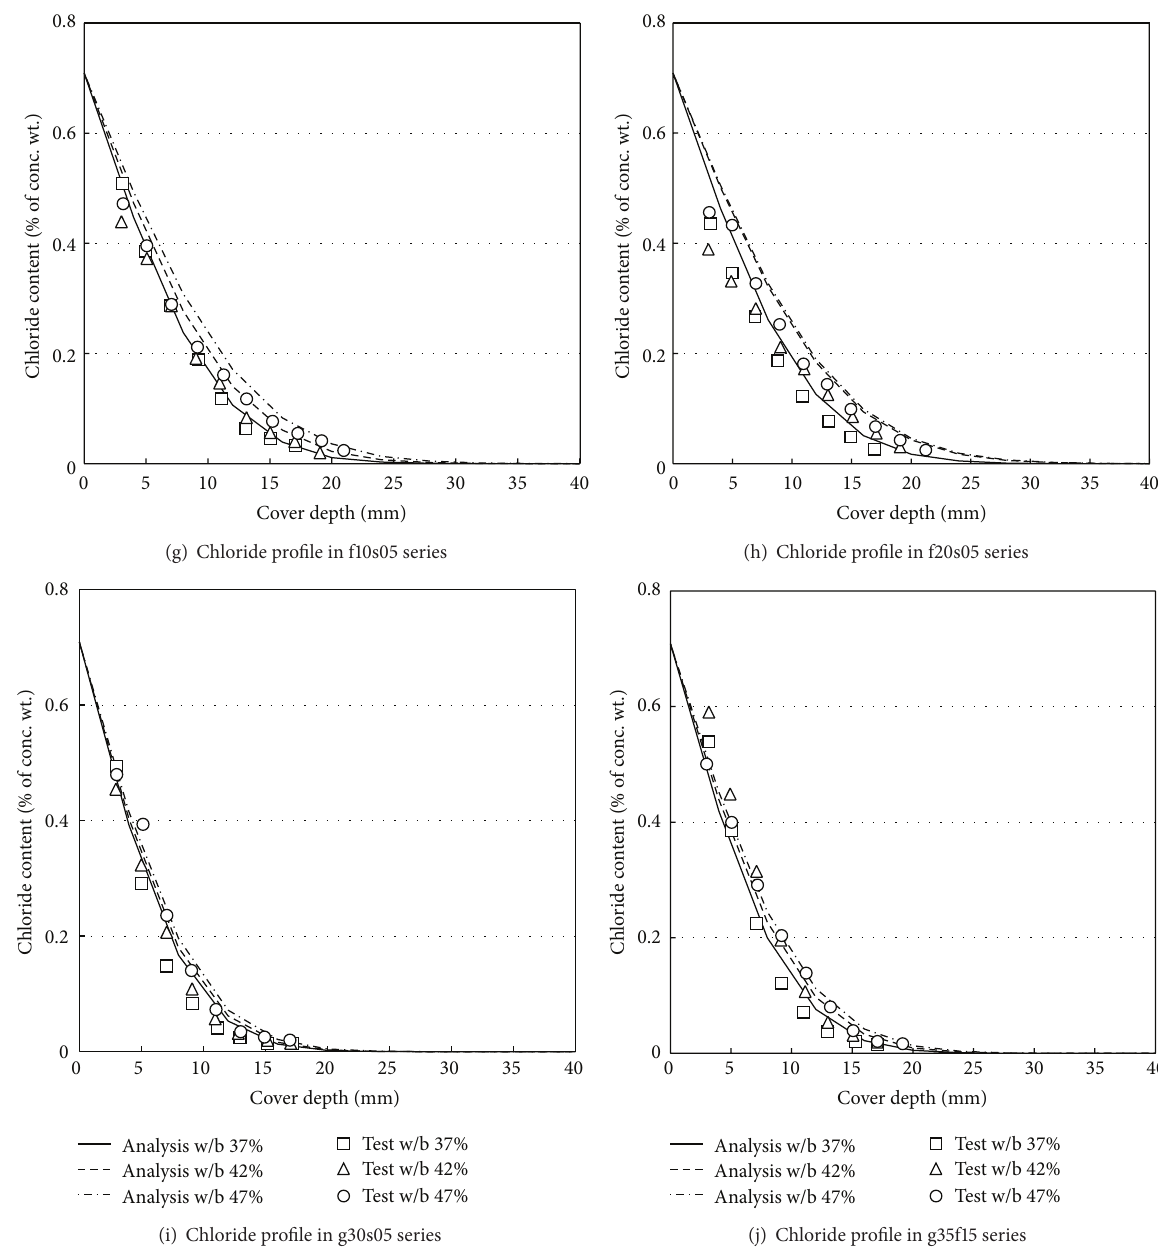
Figure 9: Comparison of chloride profile between NNA and test